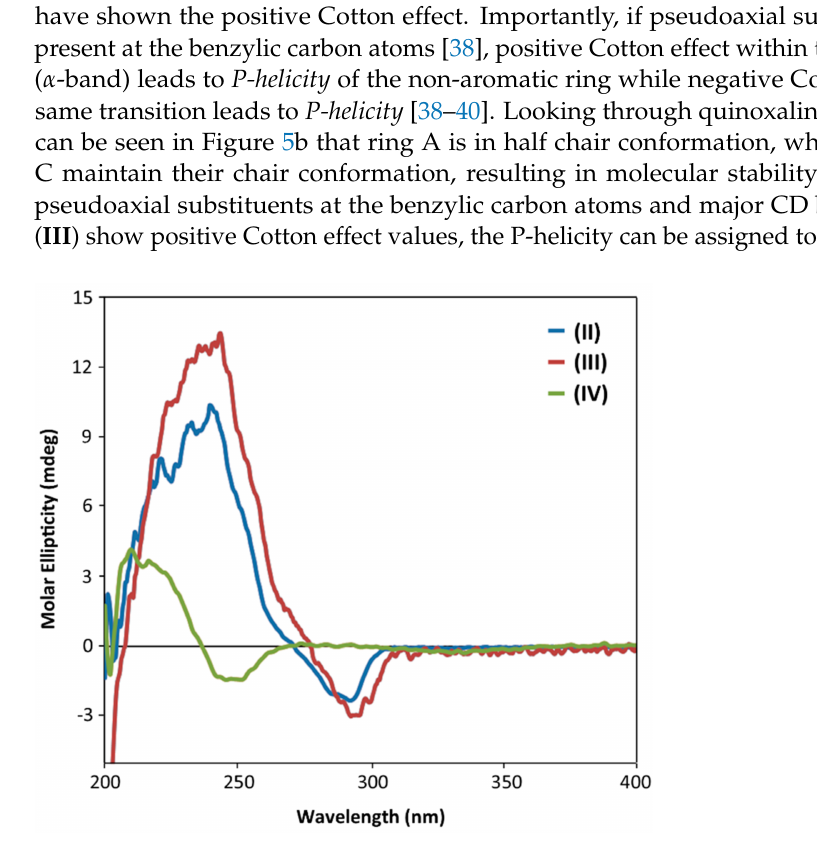
Figure 4. Comparison of CD analysis of compound (II) , (III) , and ( IV